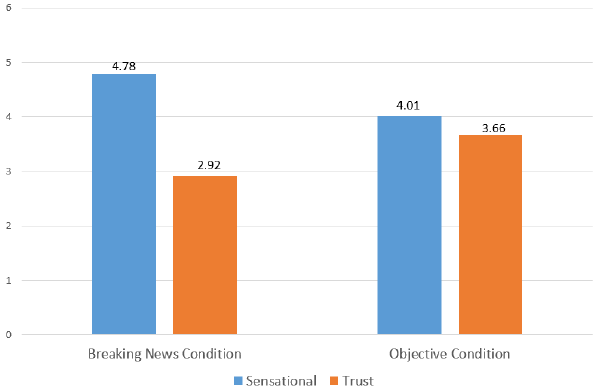
Figure 1. Descriptive results for breaking news vs. objective condition.